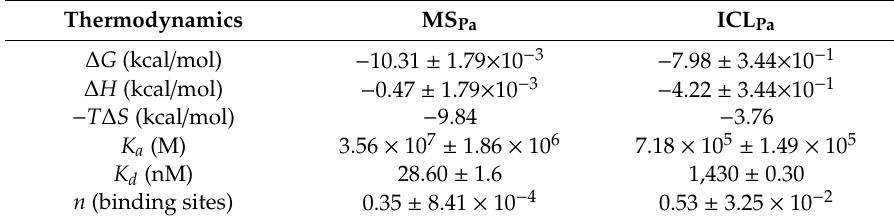
Figure 4. Isothermal titration calorimetry (ITC) data for SB002 binding to MS Pa and ICL Pa . The top panels illustrate the raw ITC data from 30 equal injections of either ( A ) MS Pa or ( B ) ICL Pa . Both interactions were exothermic. The bottom panels illustrate the respective binding isotherms obtained by plotting the integrated heat peaks against the molar ratio of protein to ligand. Table 2. Thermodynamic parameters of SB002 binding to MS Pa and ICL Pa